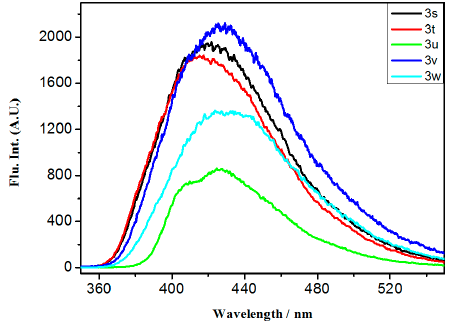
Figure 7. The emission spectra of compounds 3 ( f – r ).